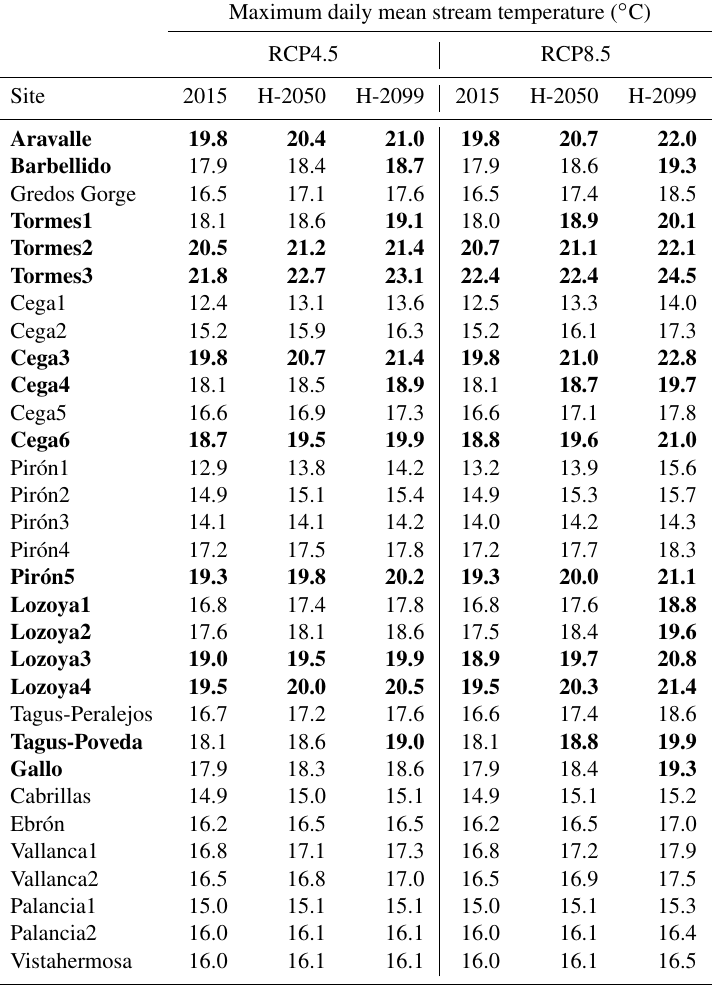
Table 7. Maximum daily mean stream temperature ( ◦ C) in each site in the year 2015 and the horizons H-2050 and H-2099. Both scenarios (RCP4.5 and RCP8.5) are shown. Bold numbers: values >18.7 ◦